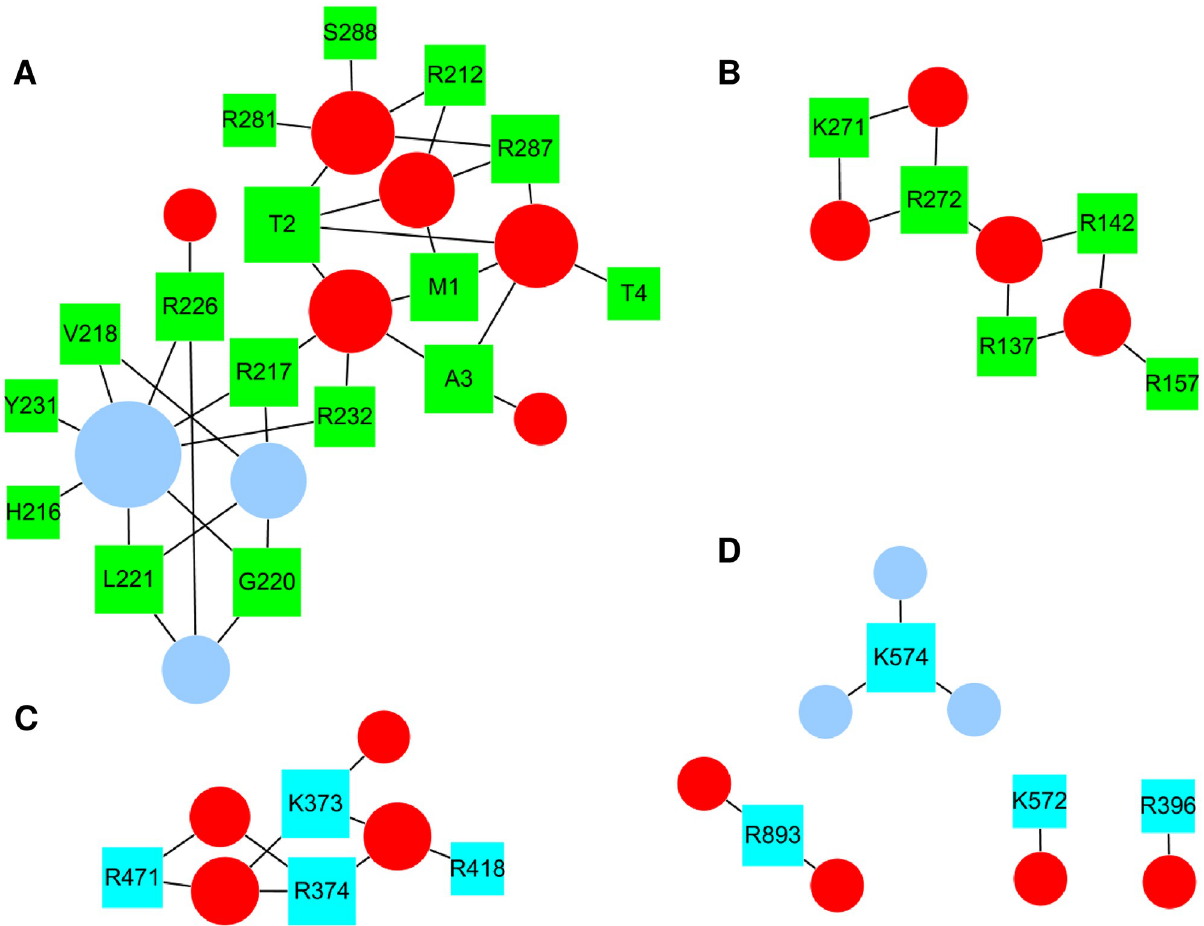
Fig 9. Network representation of hPLD2-lipid bilayer interaction networks. The networks were created based on the average connectivity during 2–3 μ s of R1 of the 10% PIP 2 system (not every link is present at every time point). Green and cyan rectangles denote hPLD2 residues in N-term and C- term, respectively; red circles are PIP 2 , and light blue circles are POPA. The size of the rectangle/circle corresponds to the degree (i.e., the number of links incident to the node). (a) The largest residue cluster (mostly in the PH domain) mediated by PIP 2 and POPA, (b) A cluster of 5 residues mostly in the PX domain linked by PIP 2 , (c) A cluster of 4 residues linked by POPA in C-term, and (d) monomers in C-term, mediated by either PIP 2 or POPA.